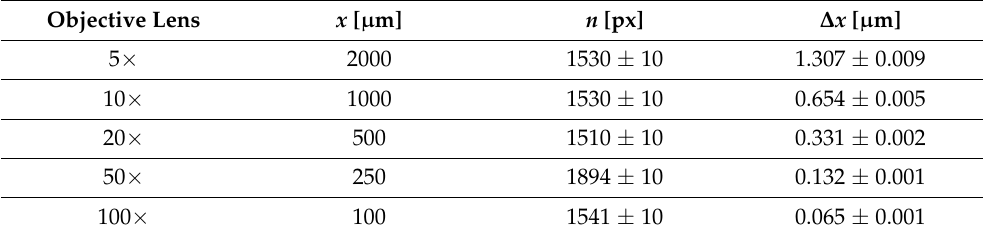
Table 1. Distance calibration of microscope objective lenses. Distance on the ruler x that spans n pixels for each objective lens gives the size of the pixel ∆ x on the image